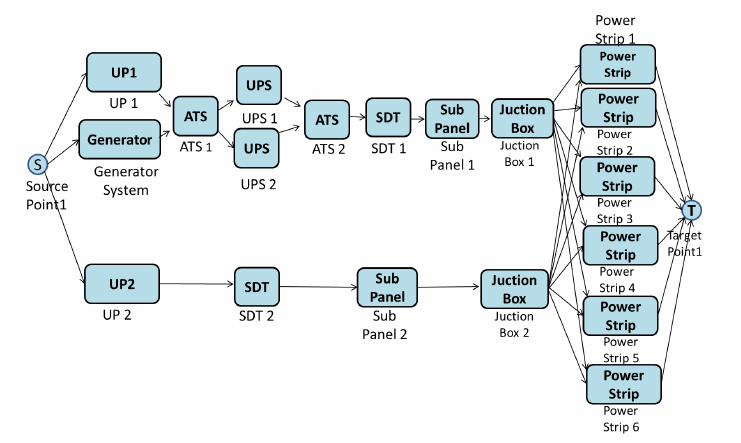
Figure 19. EFM model of Tier